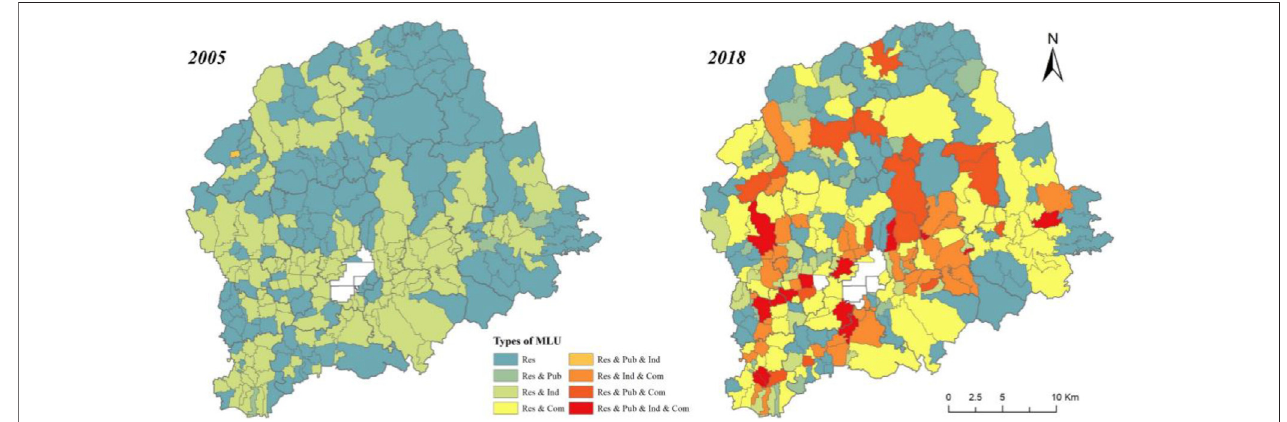
FIGURE 4 | Changing pattern of MLU in rural communities from 2005 to